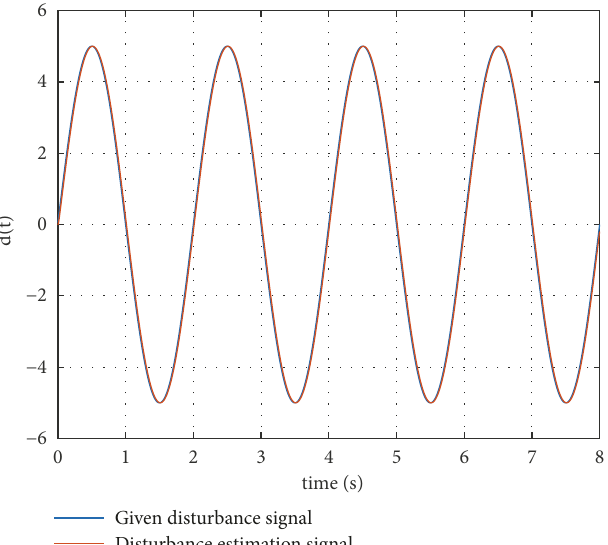
Figure 8: Disturbance observation result.